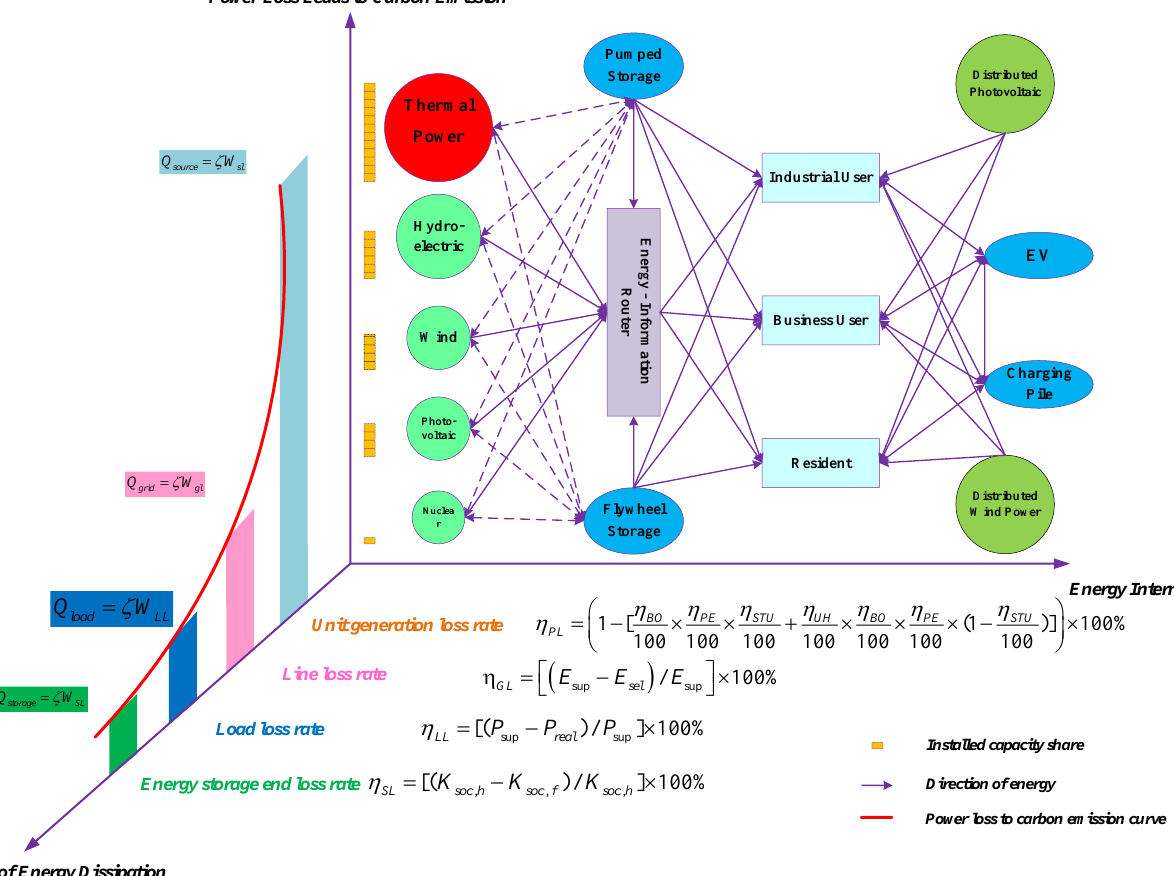
Figure 1. A 3D model of carbon emissions caused by “ source-grid-load-storage ” energy consumption.